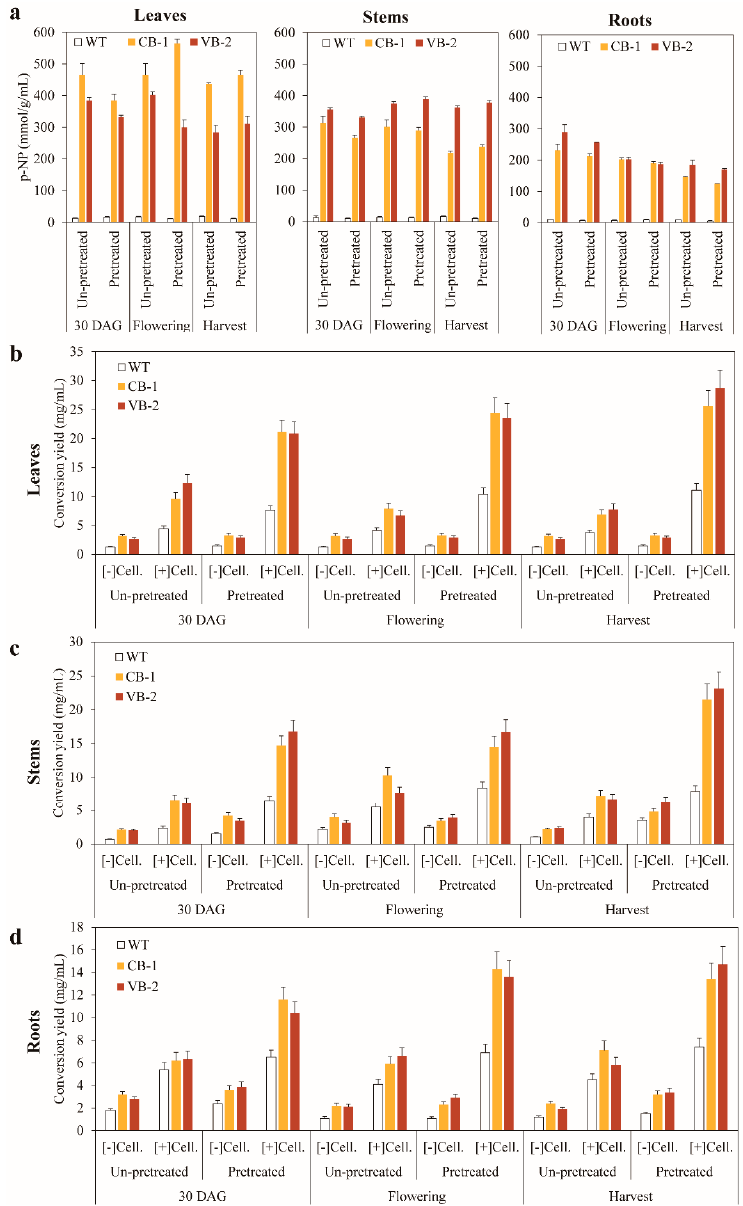
Figure 5. ( a ) β -Glucosidase activity in samples of leaves, stem, and roots of the wild-type and transgenic tobacco plants overexpressing T. maritima BglB targeted to the chloroplasts and vacuoles. Comparison of conversion yield of ( b ) leaves, ( c ) stems, and ( d ) roots after saccharification with and without additional cellulase in un-pretreated and pretreated biomasses from the wild-type and transgenic tobacco plants overexpressing T. maritima BglB targeted to the chloroplasts and vacuoles. Average values were calculated in triplicate ( n = 3) for each transgenic line and wild-type tobacco plants.